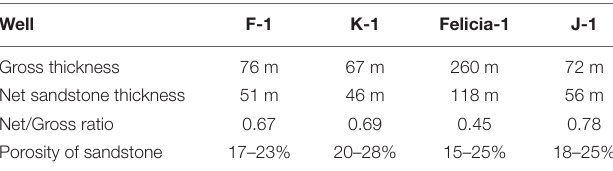
TABLE 1 | Reservoir properties of the Gassum Formation based on well-log